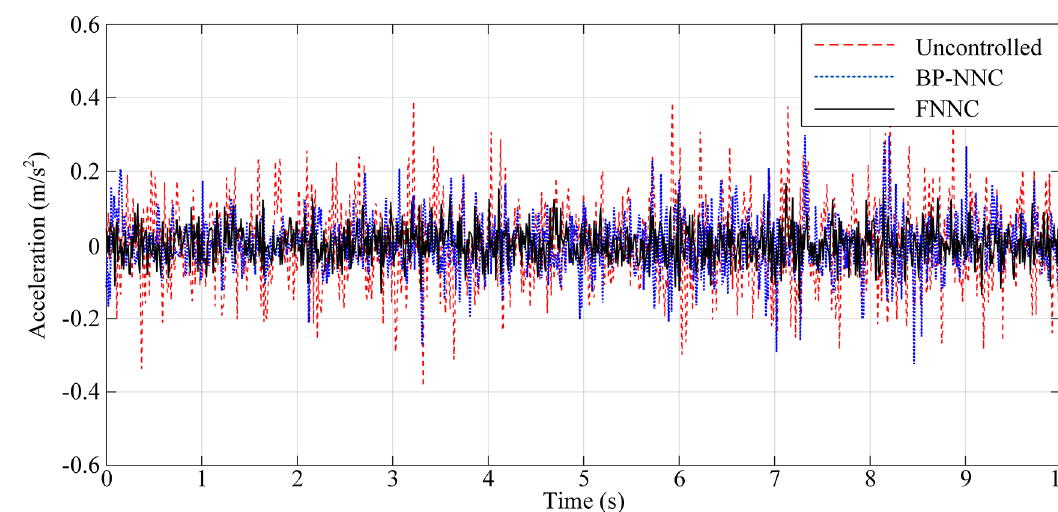
Fig. 25. Time-domain response of horizontal vibration acceleration of the elevator car frame with no